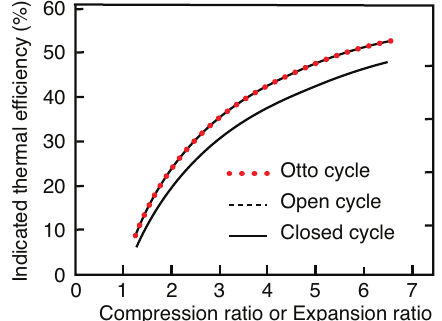
Figure 7. Comparison of the indicated thermal efficiencies of the reference actuator in open, closed, and Otto